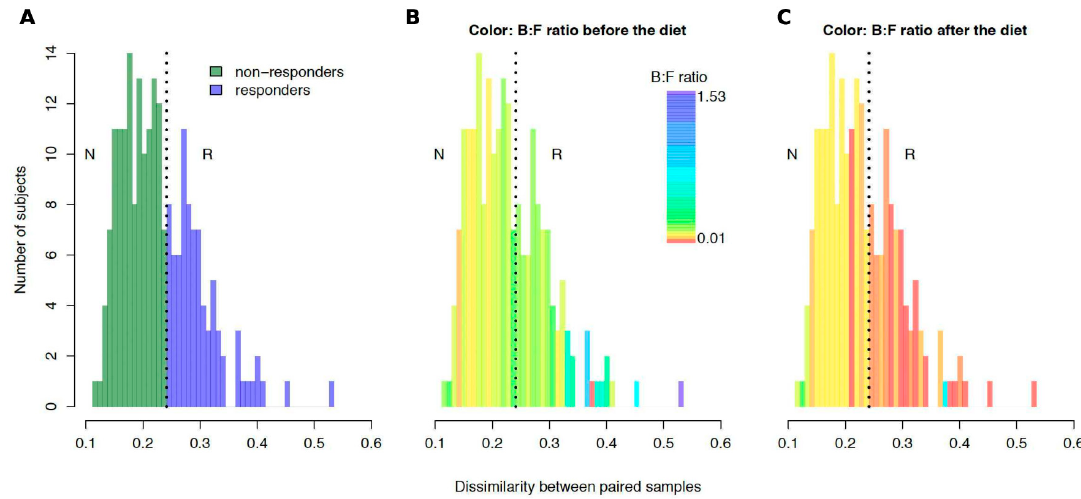
Figure 3. Interindividual variation of gut microbiota response to the diet intervention ( n = 215 subjects). Distribution of taxonomic dissimilarity between the metagenomes before and after the intervention for each subject (generalized UniFrac metric) is colored in different ways. In panel ( A ), the color denotes responders (blue) and non-responders (green). In panels ( B ) and ( C ) the color denotes the average Bacteroidetes : Firmicutes ratio for the samples collected before and after the diet, respectively).